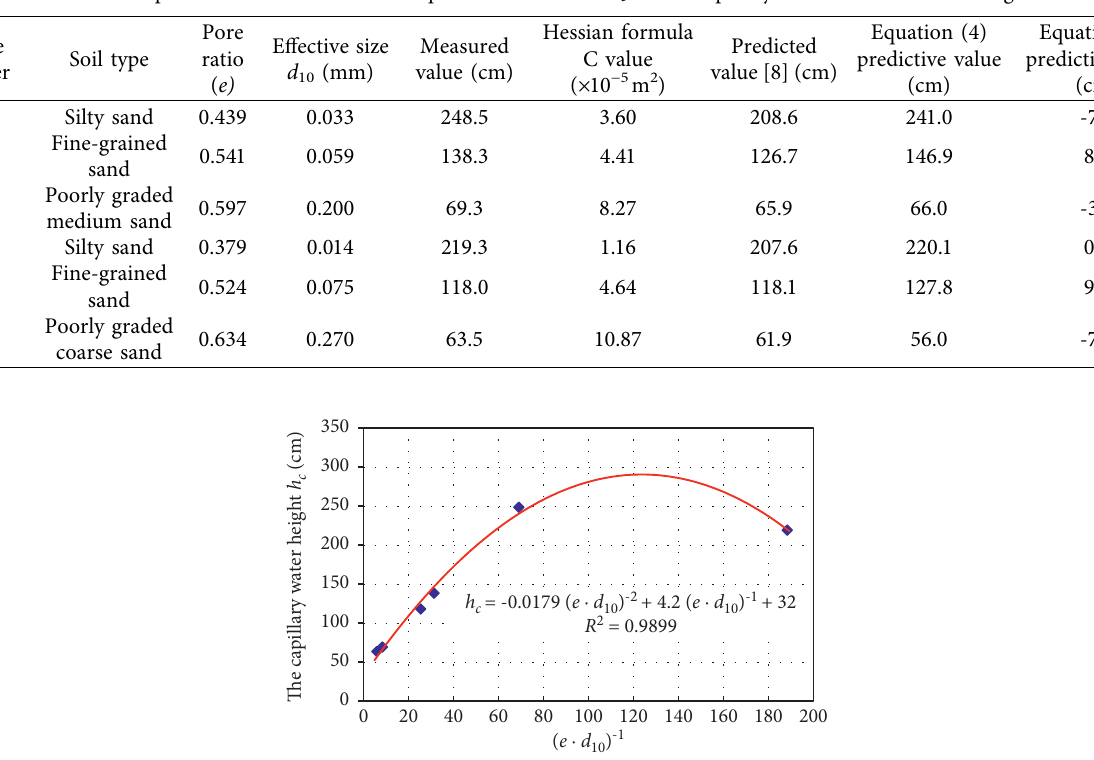
c of the capillary water rise in the coarse-grained soils.